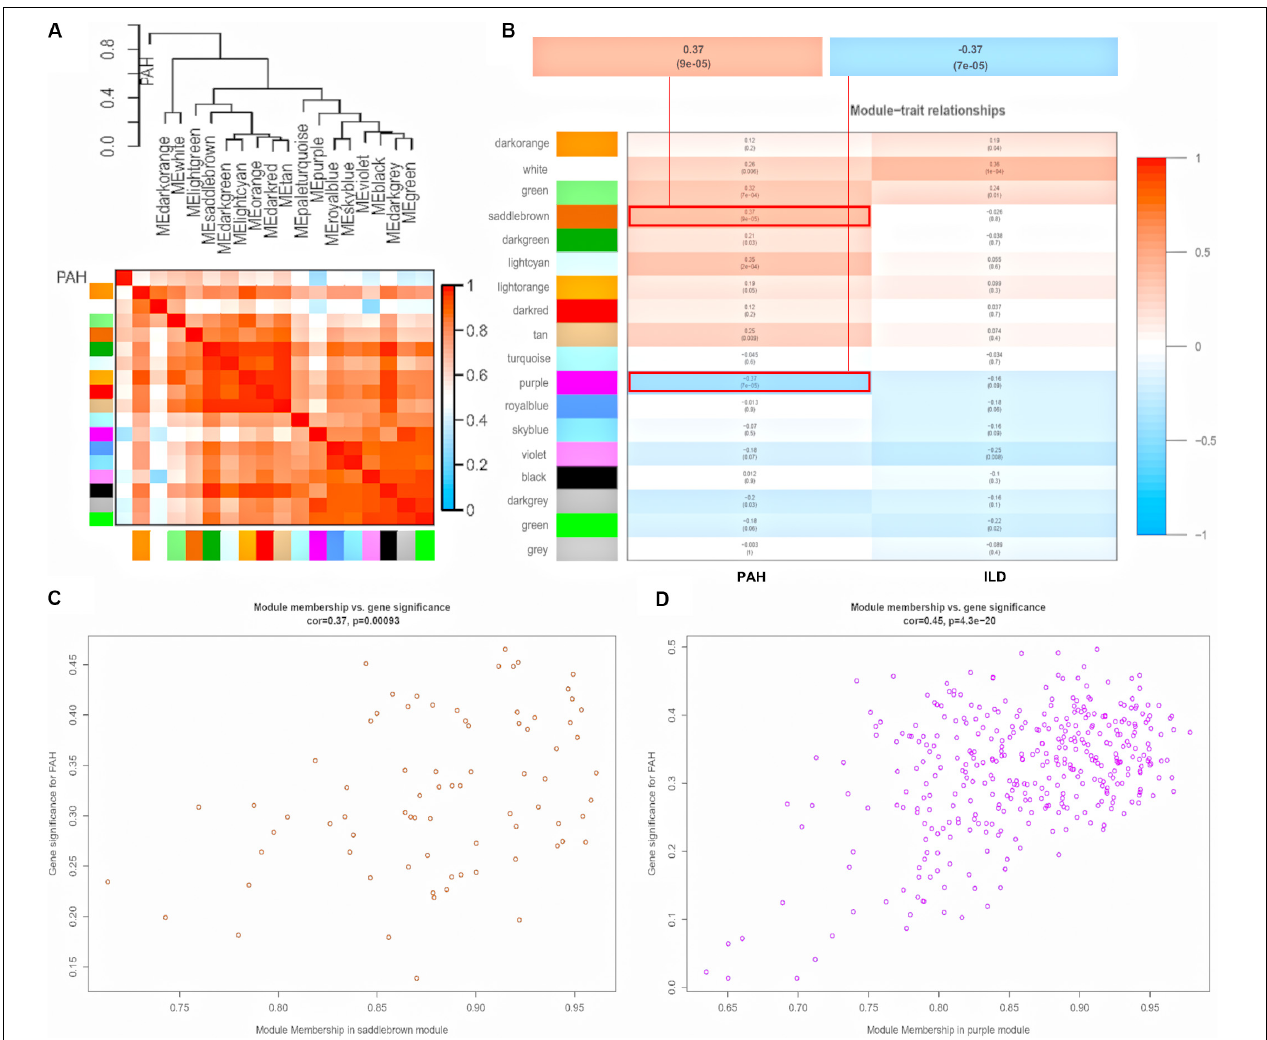
FIGURE 3 | Module-trait relationships. (A) Dendrogram and unsupervised hierarchical clustering heatmap of module eigengenes and PAH. (B) Heatmap of the correlation between module eigengenes and clinical traits. P- value is shown in each color cell coded by the correlation between modules and traits (red indicates positive correlation; blue indicates negative correlation). Scatter plot of module eigengenes in saddlebrown module (C) and purple module (D) . PAH, pulmonary arterial hypertension; ILD, interstitial lung